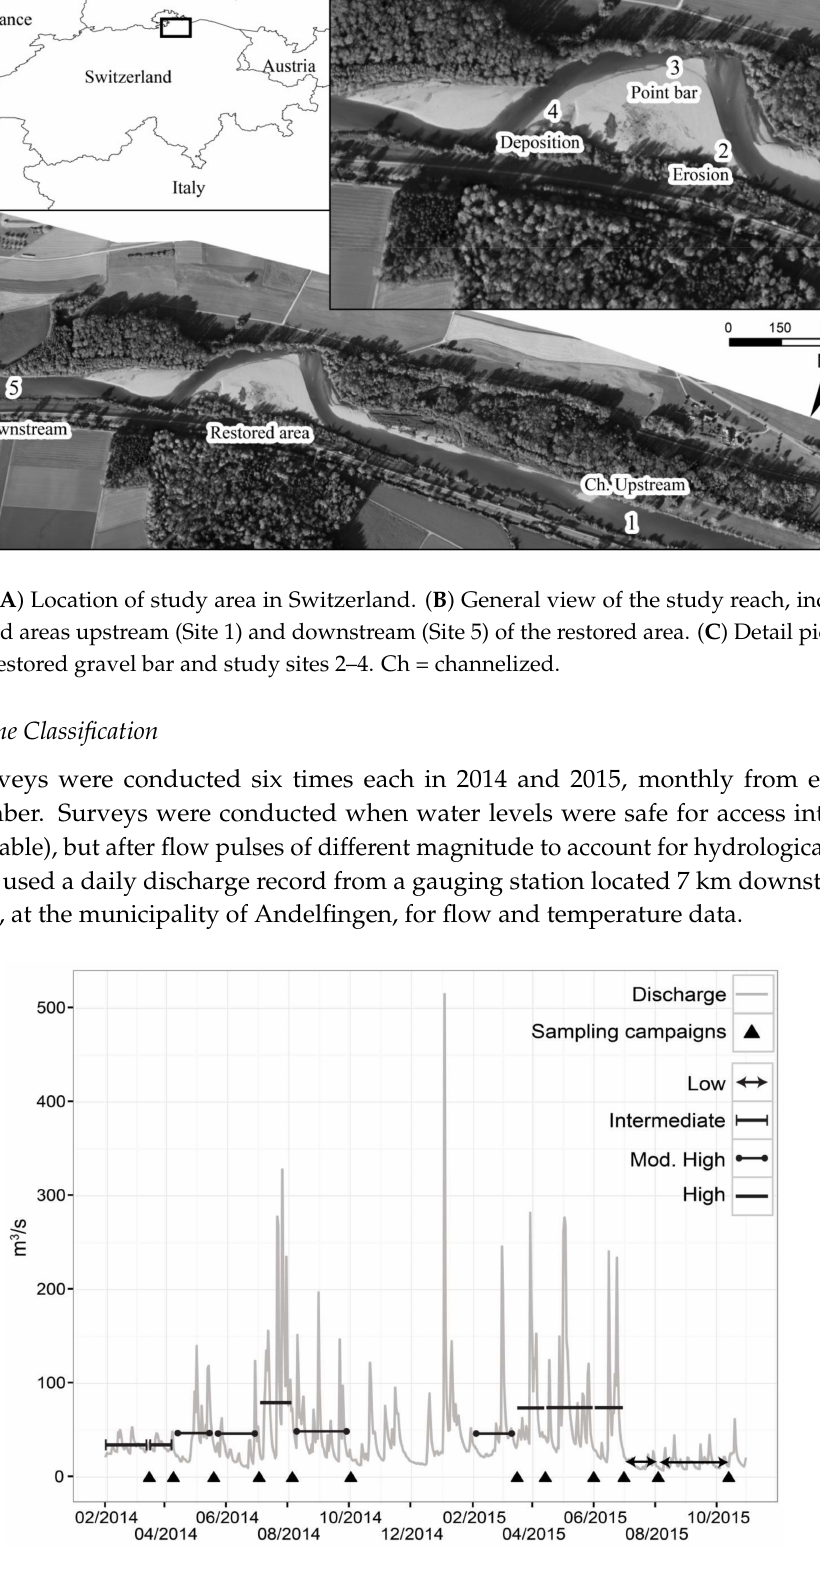
Figure 2. Hydrograph of the Thur River in 2014–2015. Black lines represent flow classes of the period affecting each sampling campaign (Mod. High = Moderately